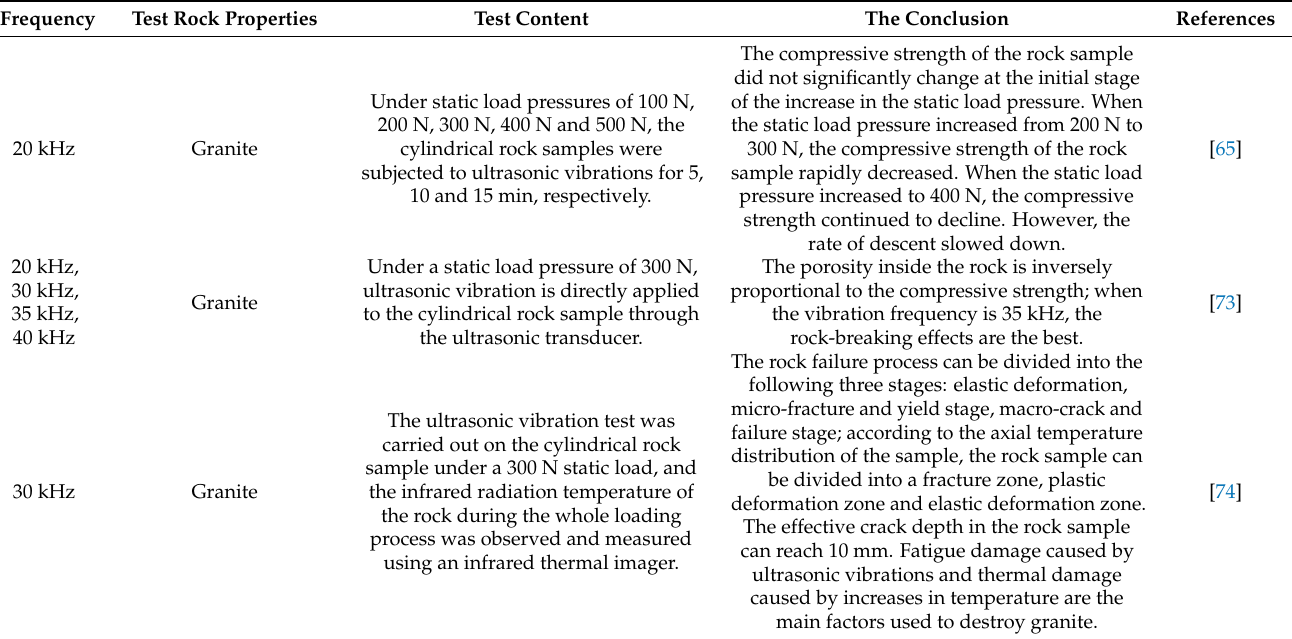
Table 2. Research progress of ultrasonic-assisted rock-breaking laboratory tests.